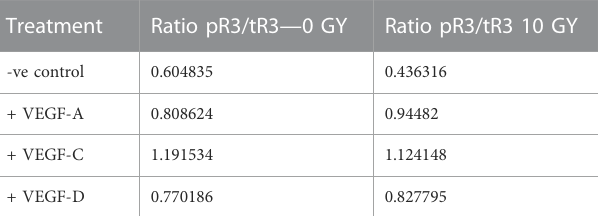
TABLE 2 Ratios of pR3/tR3 from quanti fi cation of the optical densities of the signals fromphosphorylated andtotal VEGFR-3inWesternblots.WesternBlot assays performed a minimum n =